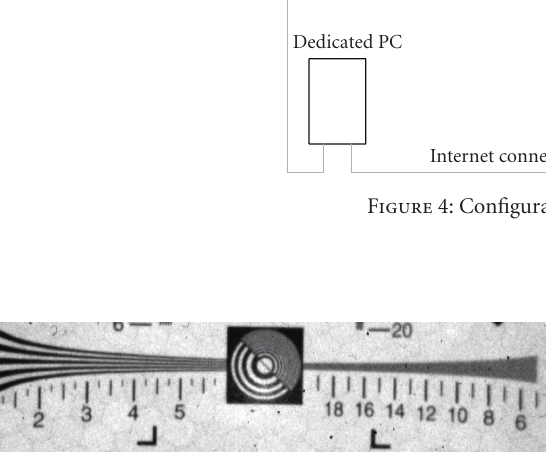
Figure 5: Fragment of the MTF test captured with image intensifier.